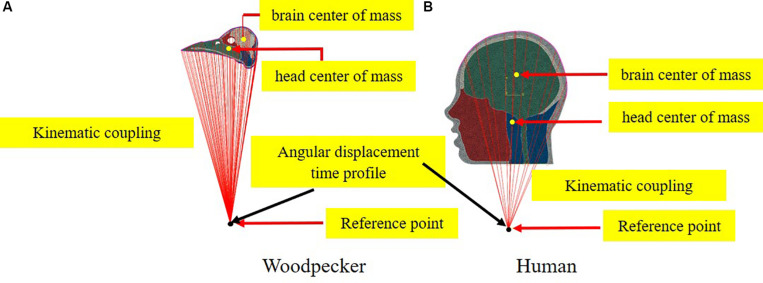
Schematic depicting the application of boundary conditions (A) woodpecker and (B) human.